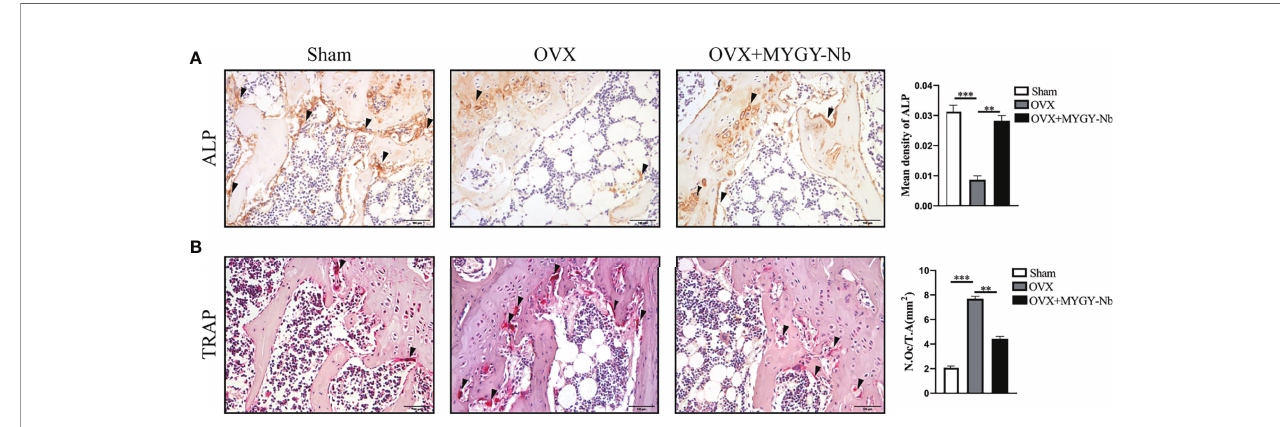
FIGURE 4 | MYGY-Nb treatment restores ALP and TRAP activity in OVX mice. (A) ALP immunohistochemical staining and quanti fi cation. (B) TRAP histochemical staining and quanti fi cation. Scale bars: 100 m m. Data were presented as means ± S.D. ** P < 0.01; *** P < 0.001. n = 6 in